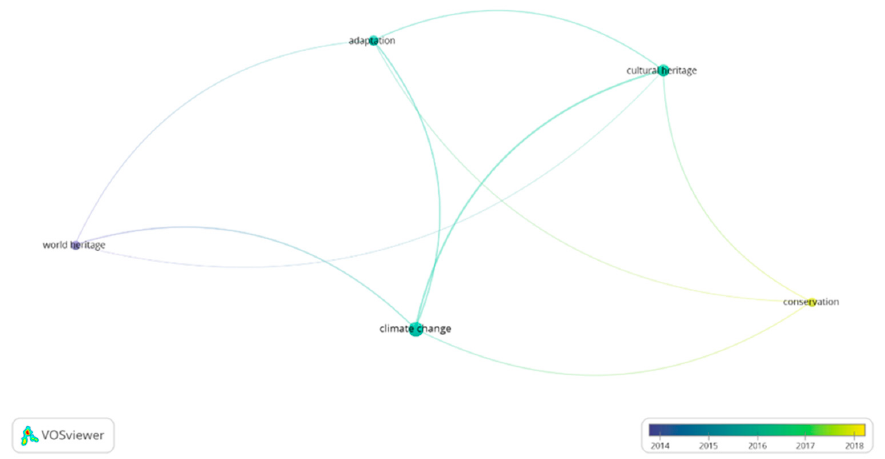
Figure 4. Network of co-occurrence of author keywords in the last 5 years. Source: own elaboration.